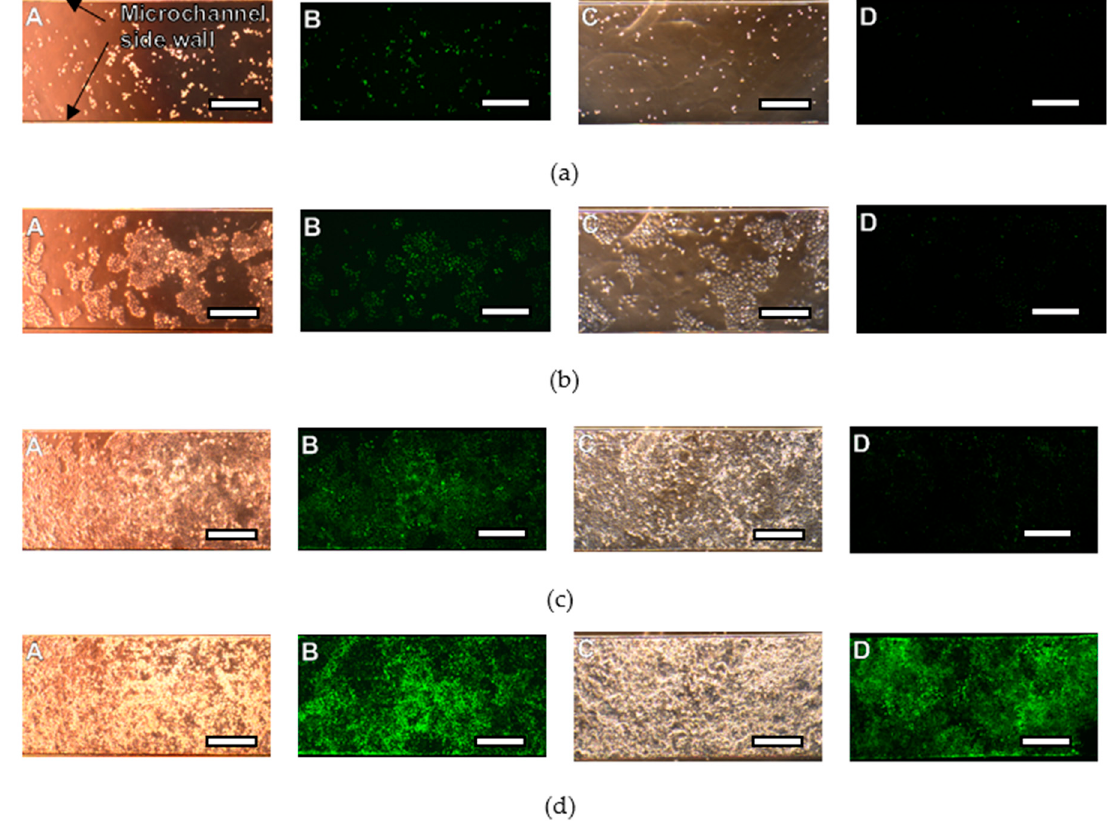
Figure 4. Bright field images and fluorescent images of HeLa cells cultured on SJI-001 and SU-8. HeLa cells were cultured 9 days in PDMS microchannel, the bottom material of which was SJI-001 and SU-8. Bright field images and fluorescence images taken within 2 h after seeding are shown in ( a ). Bright field images and fluorescence images taken 3, 6, 9 days after seeding are shown in ( b – d ) respectively. Bright field images and fluorescence images of HeLa cells on SU-8 are shown in A and B, respectively. Bright field images and fluorescence images of HeLa cells on SJI-001 are shown in C and D, respectively. The scale bar is 300 µm.